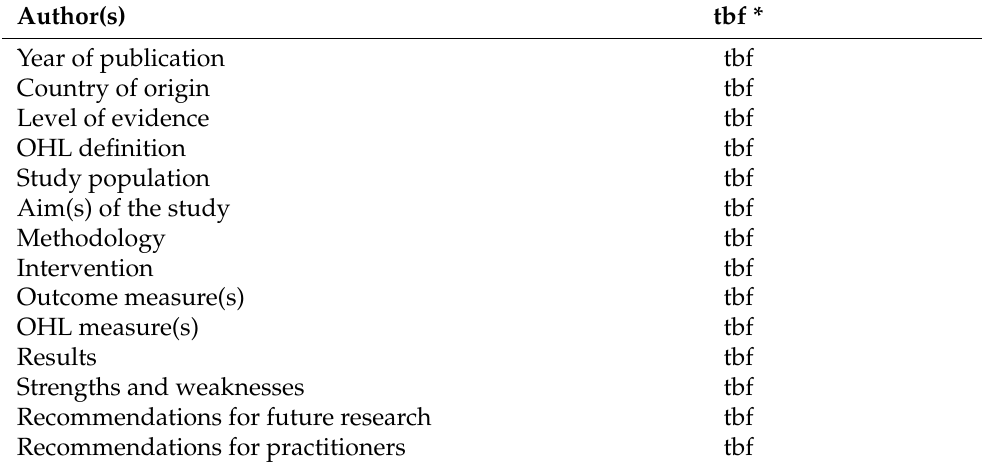
Table 5. Example of data extraction sheet,